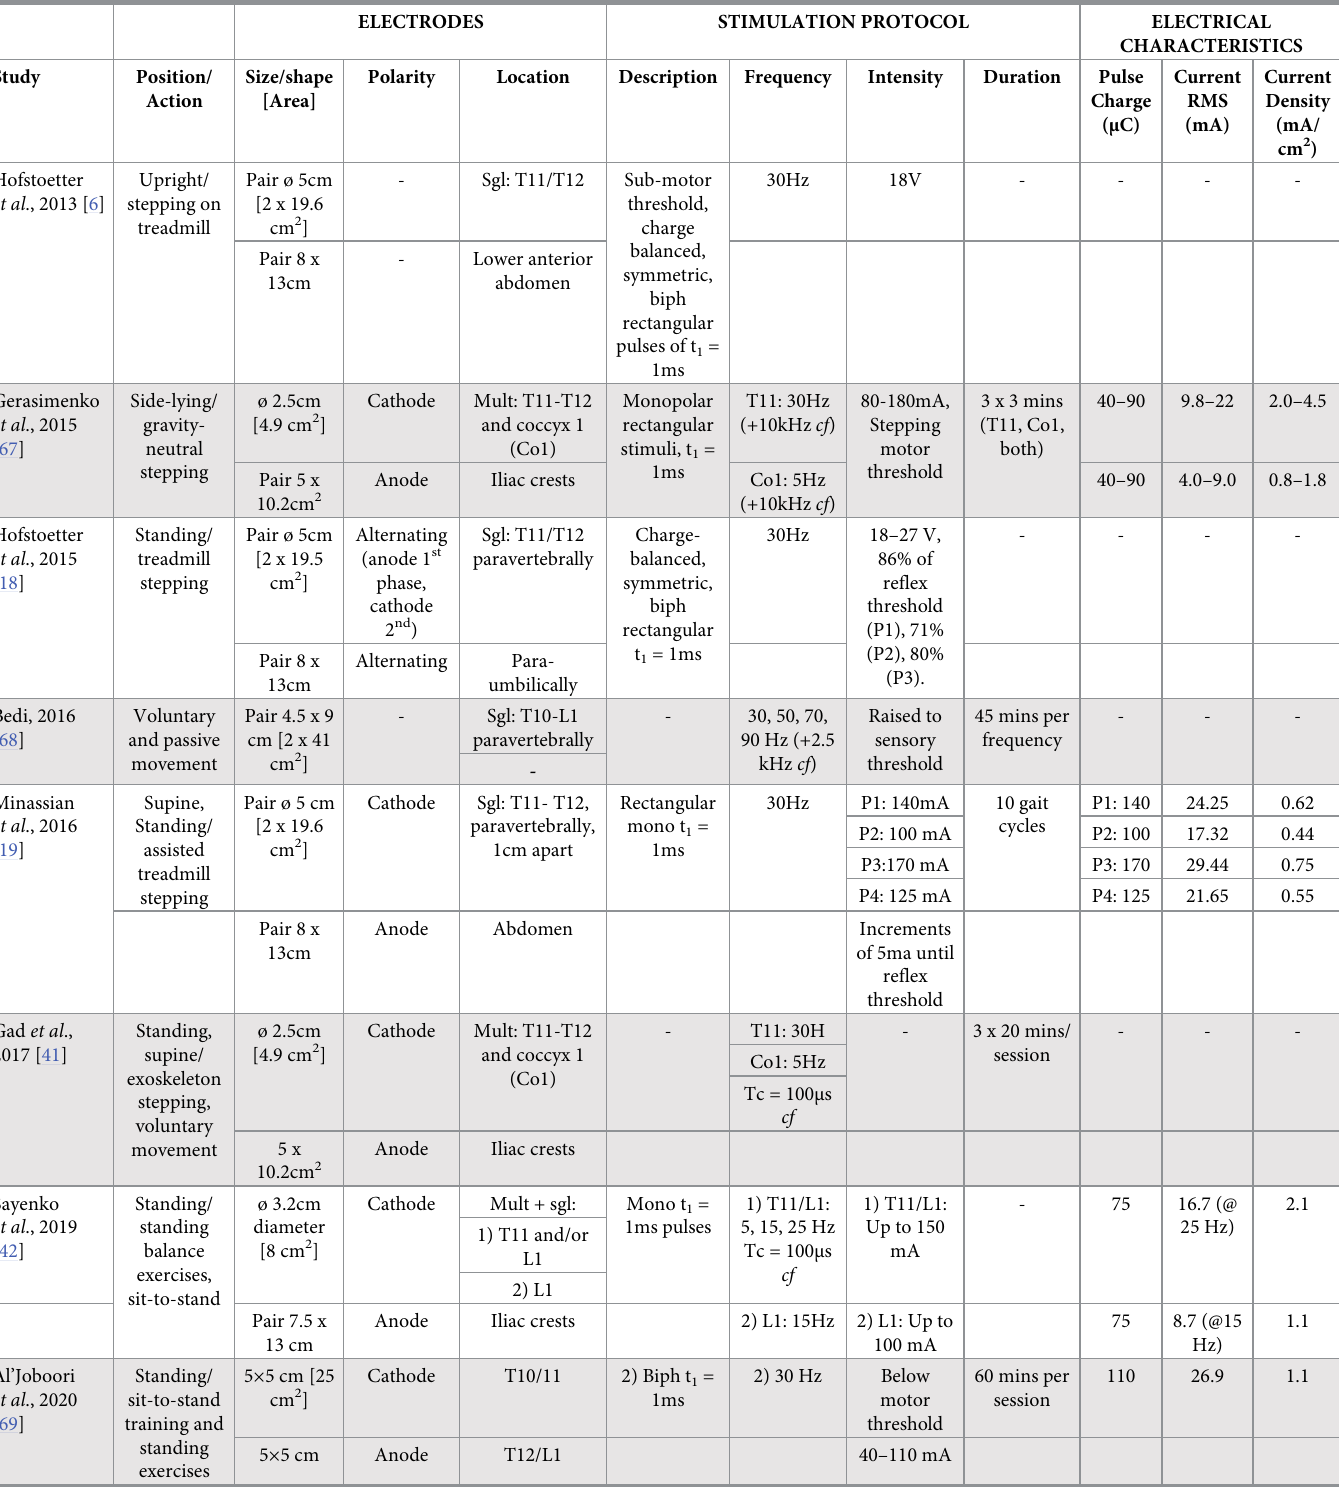
Table 7. Parameters selected for therapeutic stimulation investigating the effects of tSCS on motor rehabilitation. Stimulation parameters selected by therapeutic studies investigating the effects of transcutaneous spinal cord stimulation for motor recovery.